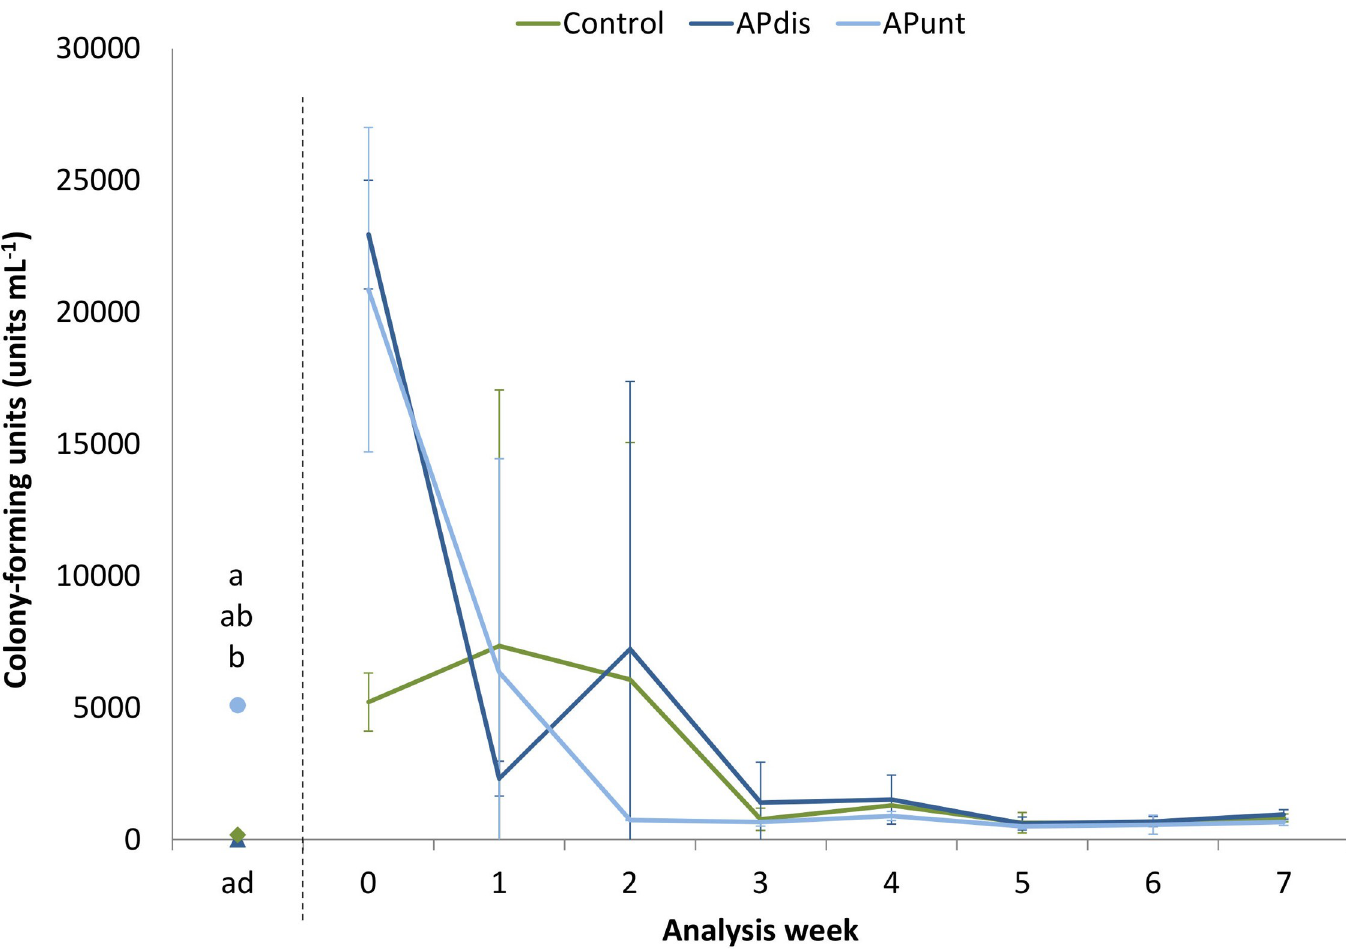
Fig 3. Content of colony-forming units (CFU) of the nutrient solution formulated with fresh water (control: 50:50, v/v fresh and rain water), fish water (AP unt ) and disinfected fish water (AP dis ) over the experimental period of 7 weeks. The data represent mean values of three repetitions per treatment ± standard deviation. Mean values were evaluated using Kruskal-Wallis test for the time after disinfection (ad) and by the Friedman test for the analysis of the consecutive experimental weeks (week 0–7) at a level of p < 0.05. Significant differences are indicated by different small letters and listed from top to bottom in the following range: AP unt , control, and AP dis .